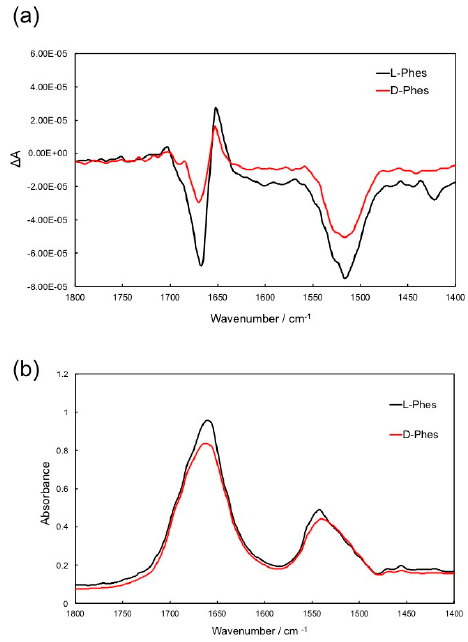
Figure 2. ( a ) Vibrational circular dichroism (VCD) and ( b ) IR spectra of L-Phes (black) and D-Phes (red) in KBr pellets.